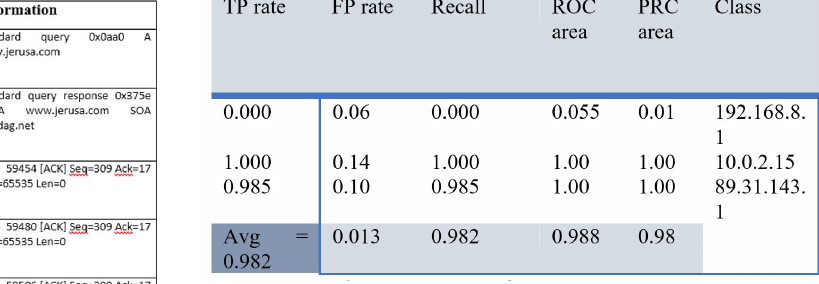
Figure 6. Truth Table for